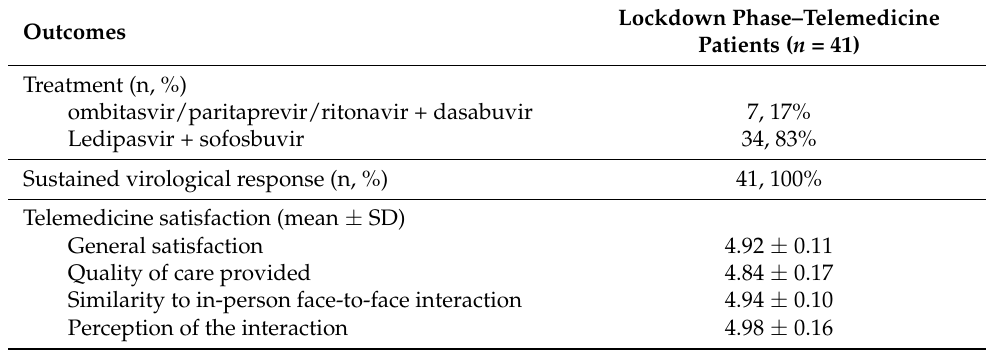
Table 2. Outcomes for telemedicine